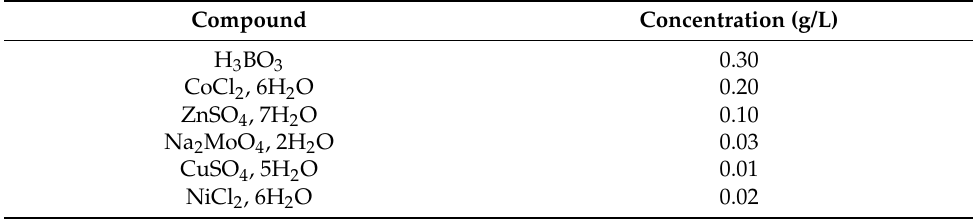
Table 5. Composition of the trace compound